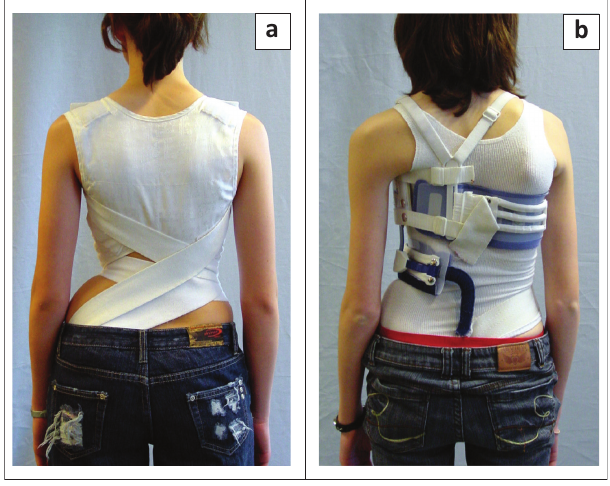
FIGURE 5: (a) Soft braces as available today. SpineCor for a right thoracolumbar curve and (b) TriaC brace for a right thoracic curve. Clinically no real corrective effect is visible.